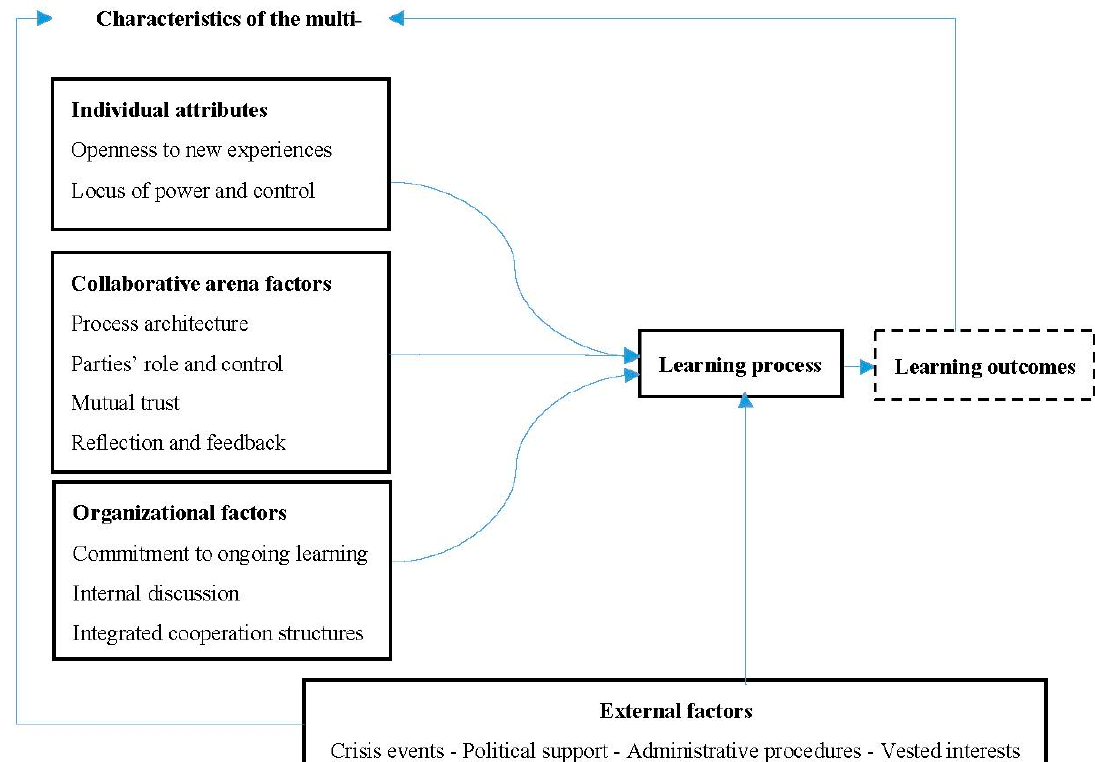
Figure 1. A framework for analyzing social learning.